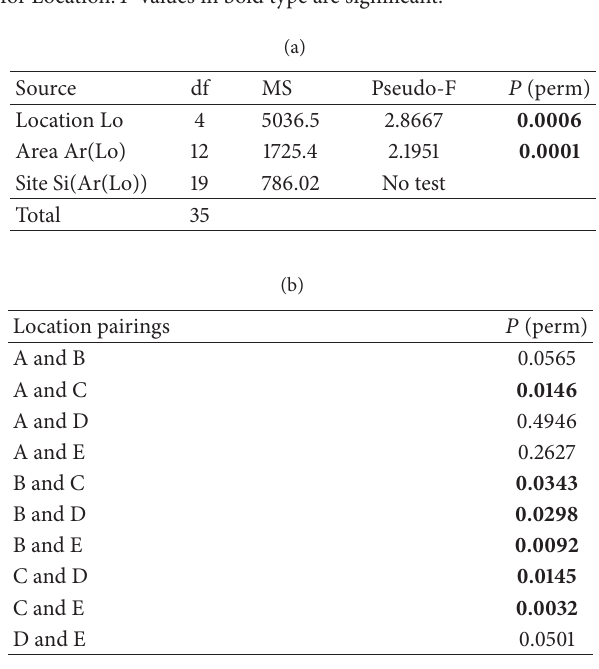
Table 3: SIMPER analysis to determine the taxa whose abundance contributes most to the similarities seen between Locations for (a) abundant/encrusting and (b)